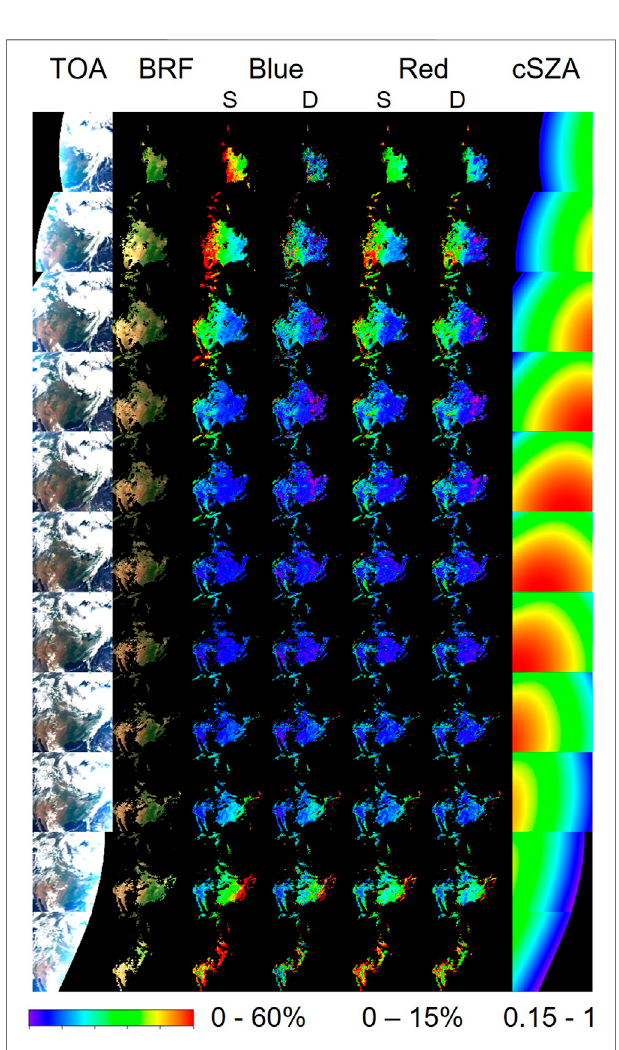
FIGURE 4 | Analysis of different schemes of atmospheric correction of EPIC over North America on June 13, 2020. The fi rst and second columns show the EPIC ’ s TOA and atmospherically corrected RGB BRF images. Columns 3 – 6 show the relative difference between anisotropic BRF and Lambert( ρ L )re fl ectance(BRF- ρ L / ρ L ) × 100%intheBlueandRedbands,where BRF was computed using the scaling (S) and the “ direct term ” (D) methods. The last column displays the cosine of the solar zenith